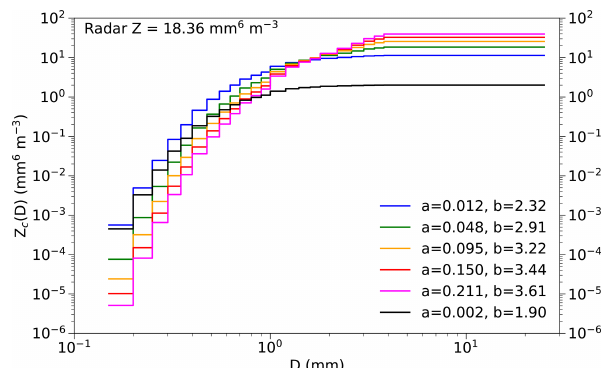
Figure 4. Z c (D) as a function of D derived using modified m – D coefficients from BF95 (black) and from the 5th (blue), 25th (green), 50th (orange), 75th (red), and 95th (magenta) percentiles from the set of equally plausible m – D coefficients in the order of increasing b and a values for the 14:16:30–14:32:15UTC flight leg on 20 May 2011. Mean radar reflectivity matched at the aircraft’s position for the same period is listed in top